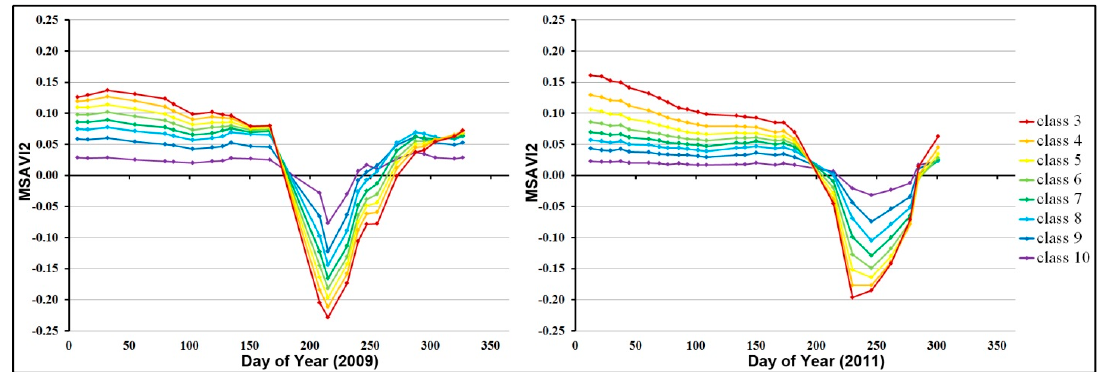
Figure 8. Divergence of MSAVI 2 for eight NDPI classes from MSAVI 2 of the reference phenology for corresponding dates in years 2009 ( left ) and 2011 ( right ). Classes 1 and 2 are not displayed for clarity.